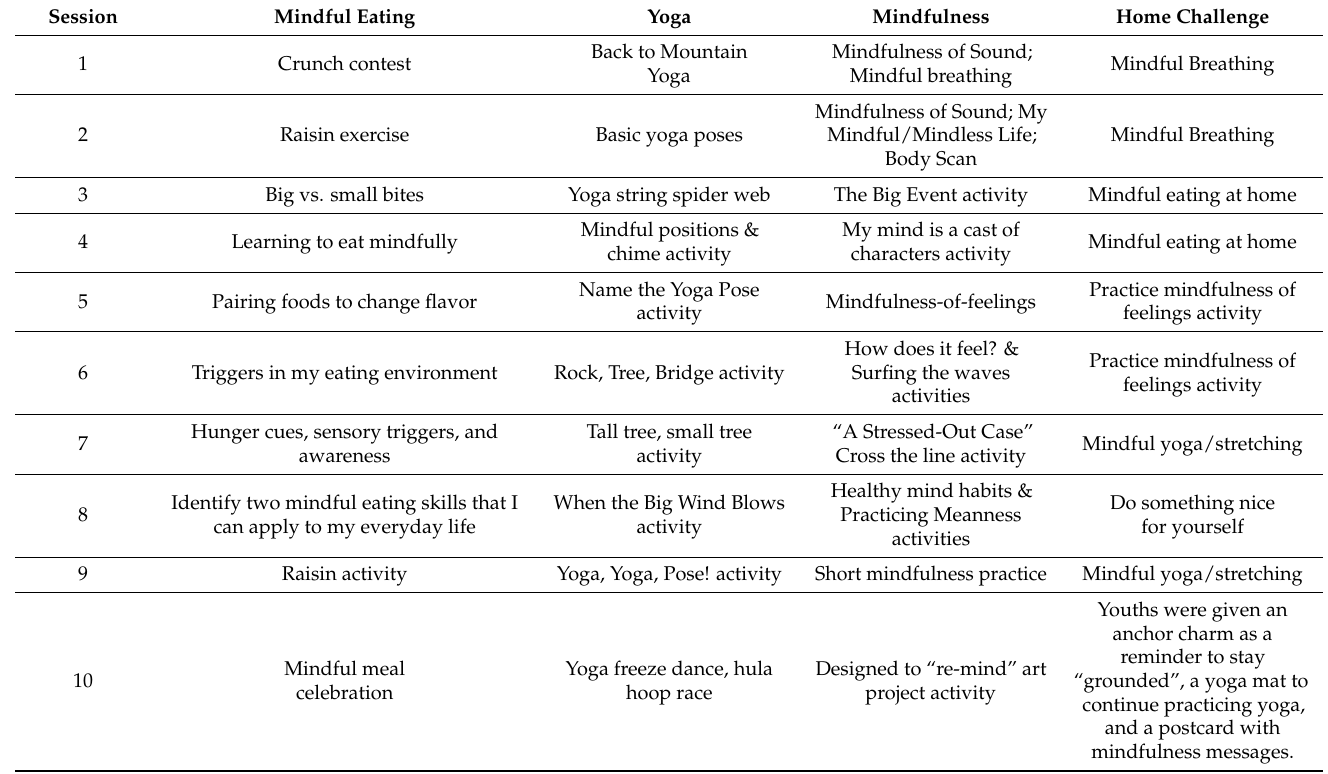
Table 2. Summary of Planned Intervention